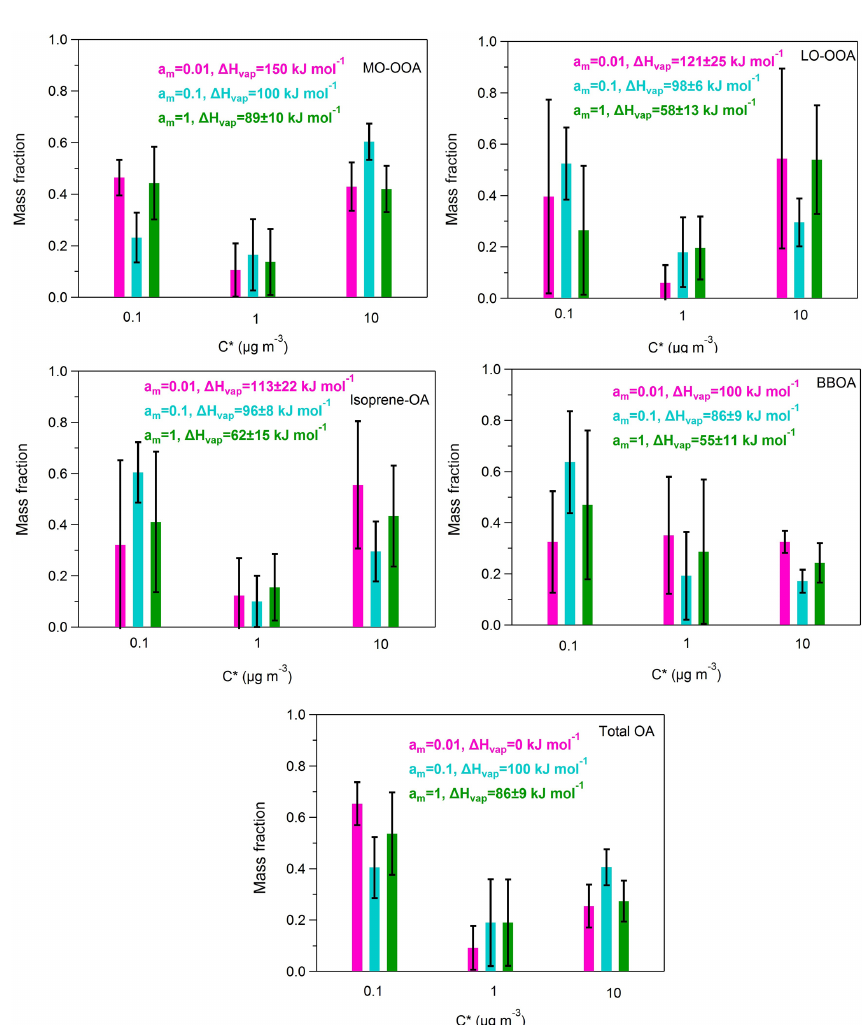
Figure A4. Predicted volatility distributions of the OA PMF factors and total OA. The error bars are estimated using the approach of Karnezi et al. (2014). The green bars represent the results for a m = 1 (base case), the cyan bars correspond to the solution for a m = 0 . 1 and the pink bars are the results for a m = 0 .